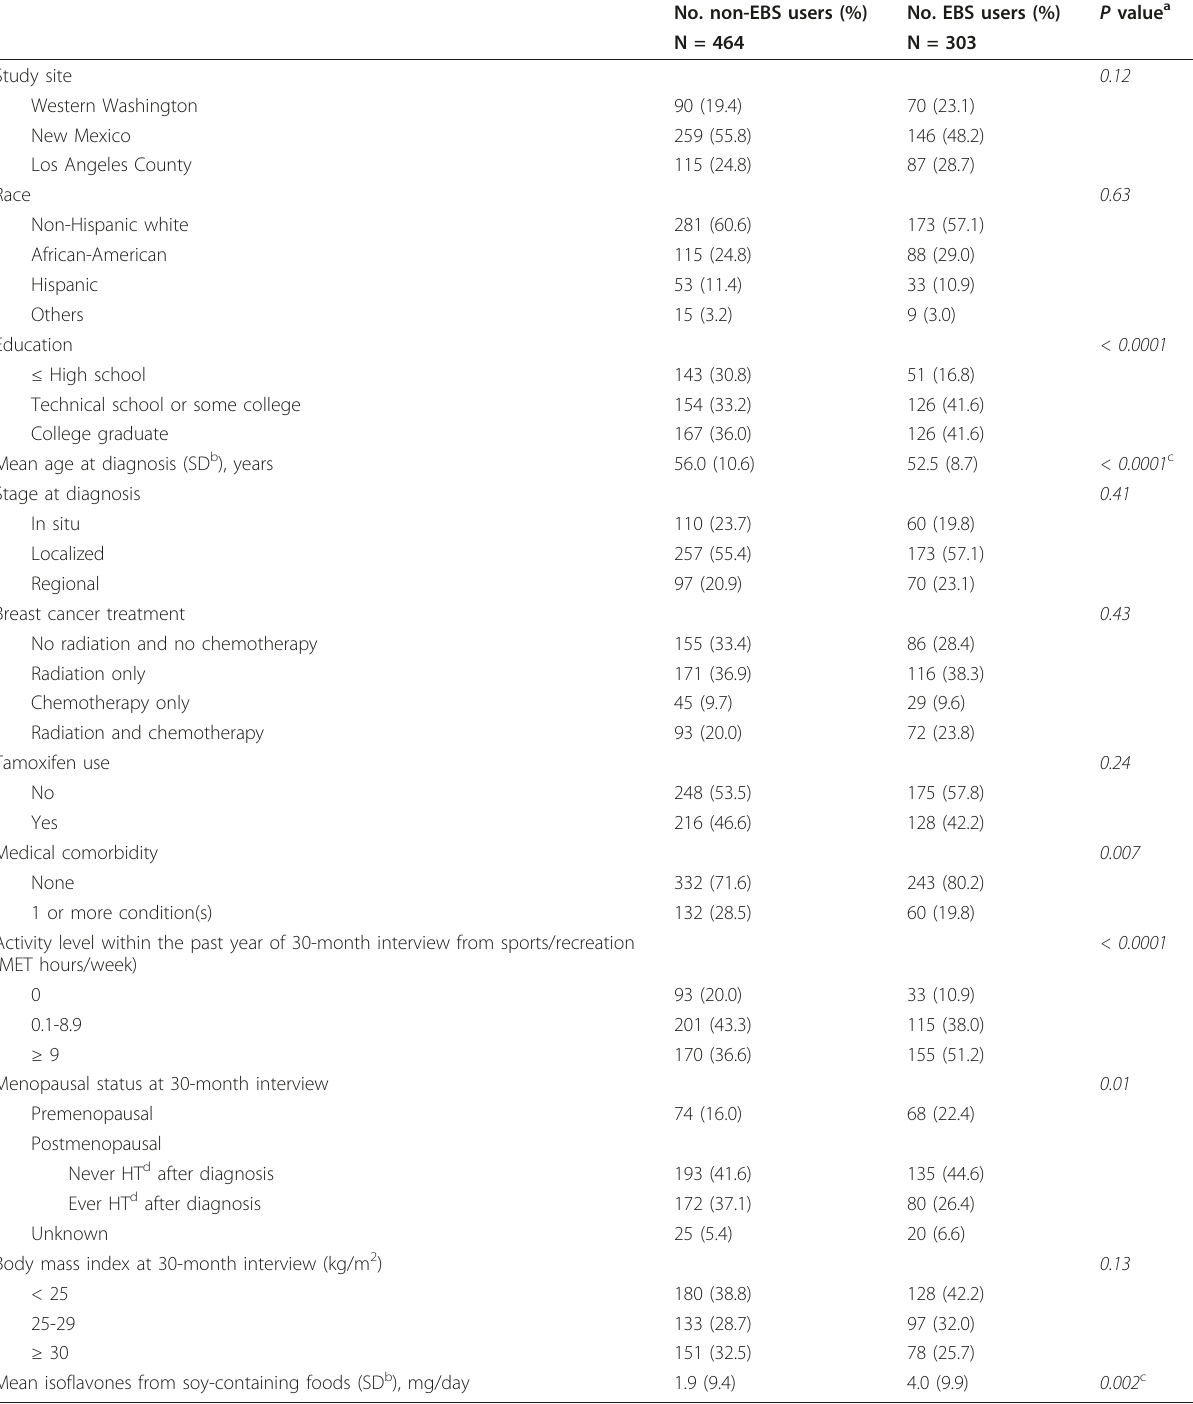
Table 1 Study population characteristics by estrogenic botanical supplement (EBS) use